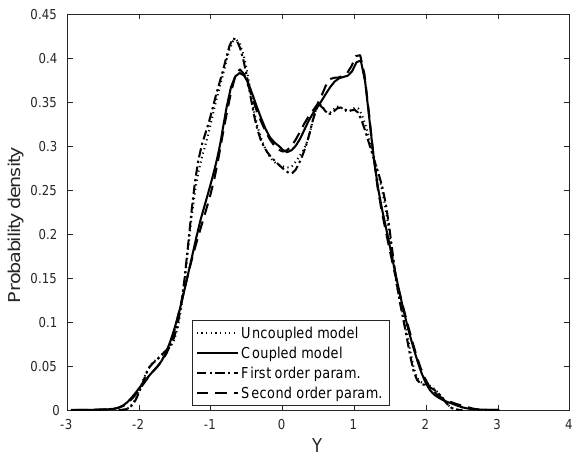
Figure 5. Probability density of the Y variable. For case τ = 5, the Lorenz 63 model acts as a fast forcing on the Lorenz 84 model.